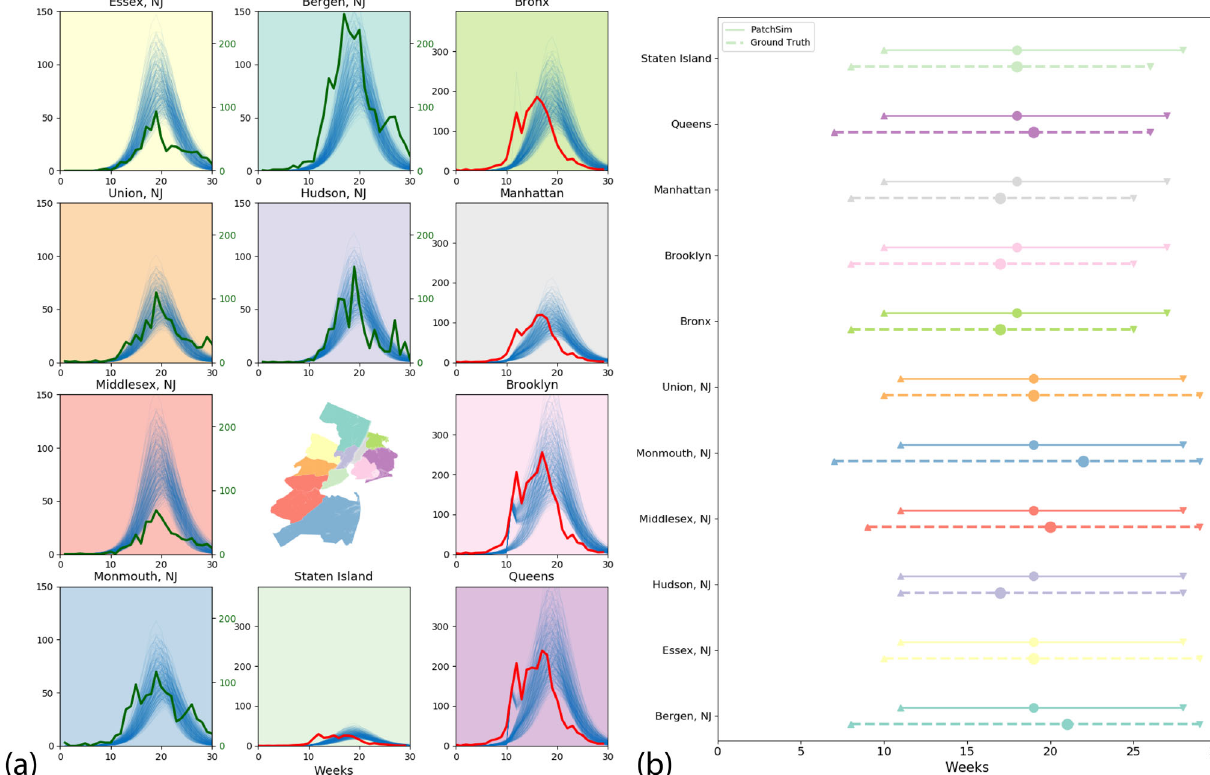
Fig. 7 Extrapolation for New Jersey counties adjacent to NYC. a Simulated trajectories (thin lines) along with ground truth (bold lines) shown for the fi ve boroughs of New York City, and the six neighboring counties in New Jersey. The plots are color-coded to match the respective county in the inset map. b Comparison of summary statistics (onset time, peak time, and end of season) for each of these counties. Onset and end of season is de fi ned with respect to a threshold of 10% of peak